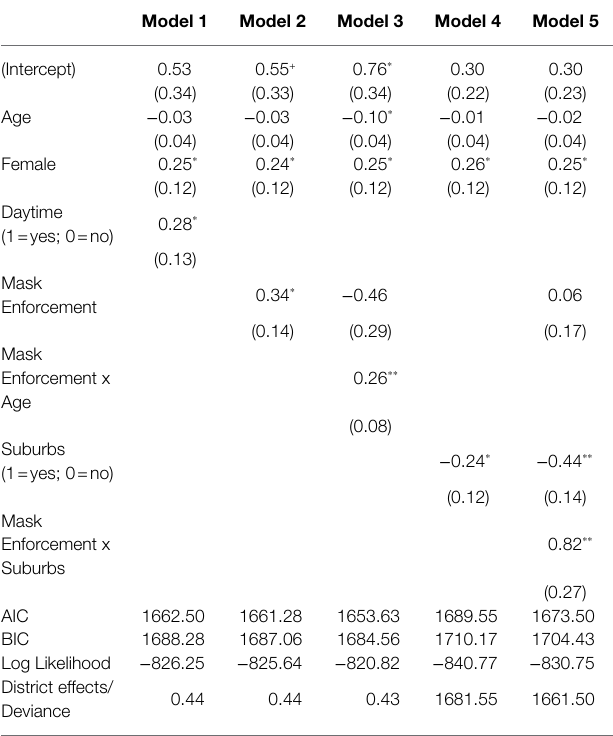
TABLE 1 | Individual and situational factors that impact mask usage in